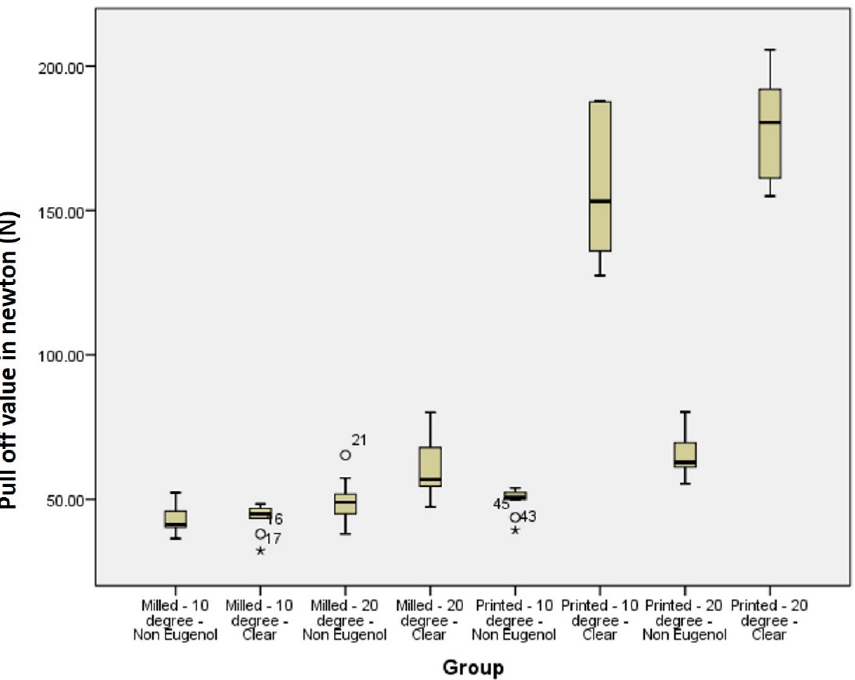
Figure 7. Box plot showing pull-off force values (N) from groups 1-8 performed using the post-hoc Bonferroni test.